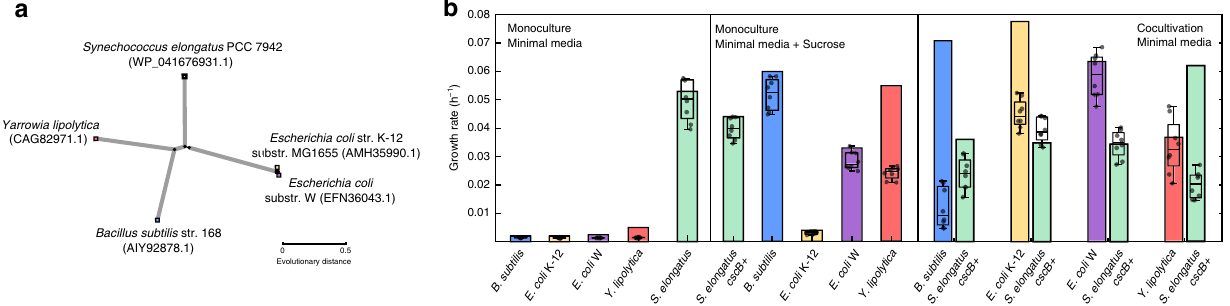
Fig. 1 Community members and growth performance. a Neighbor-joining tree based of almost full-length 16S rRNA gene sequences, showing phylogenetic relationships between S. elongatus PCC7942 and the heterotrophic species used here. GenBank accession numbers are given in parentheses. b The bar plot depicts growth rates predicted using CM-models. Boxplots show experimental validation using at least six experimental replicates, the central mark indicates the median, and the bottom and top edges of the box indicate the 25th and 75th percentiles, respectively. The whiskers extend to the most extreme data points not considered outliers. The fi rst panel shows growth in monoculture using minimal media without an organic carbon source. The second panel shows growth rates during monoculture, while using minimal media with additional sucrose. The third panel shows results obtained when combining S. elongatus cscB + with all heterotrophs in minimal media. Source data underlying Fig. 1b are provided as a Source Data